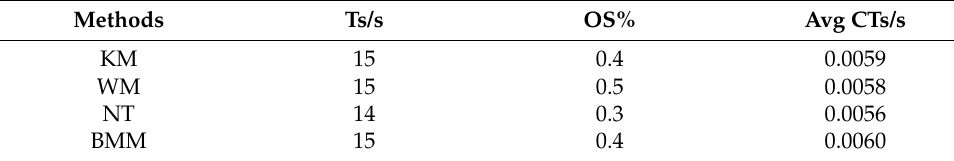
Table 6. The parameters of the IT2FPID, PID, and T1FPID controllers.